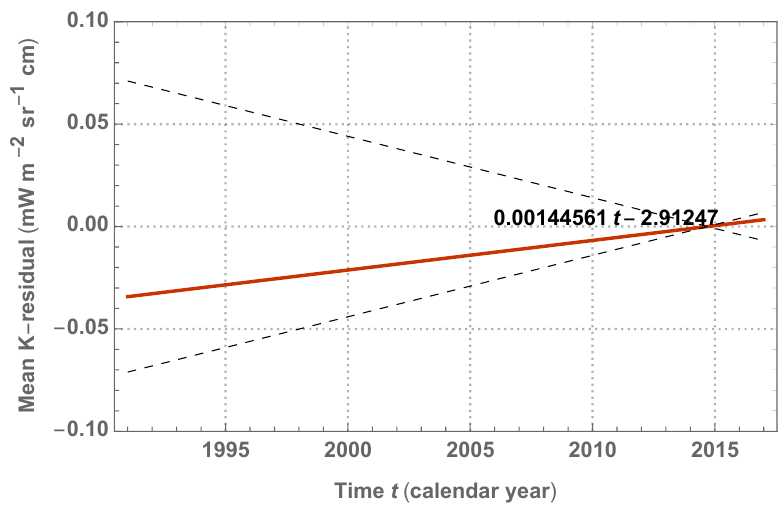
Figure 8. Trend of the mean harmonised K -residual from all sensor pairs over time. Dashed lines roughly indicate the requirement of GCOS on the decadal stability of the Sea Surface Temperature essential climate variable, which is 0.03Kdecade − 1